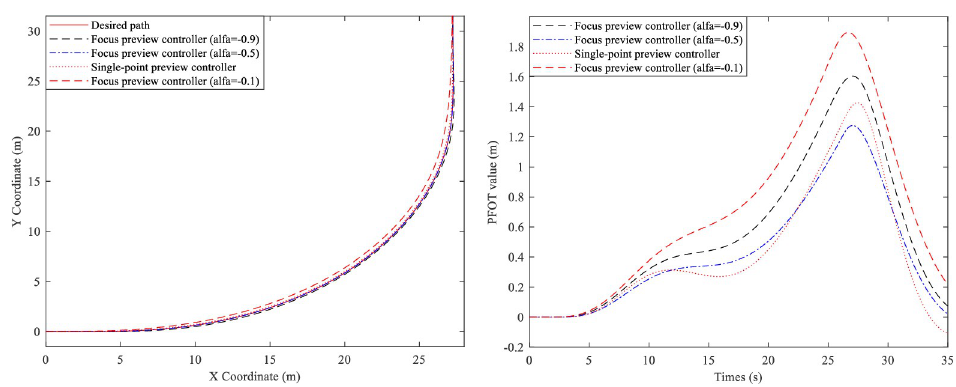
Fig 9. 90˚ turn simulation. (A) Trajectory curves. (B) POFT values.